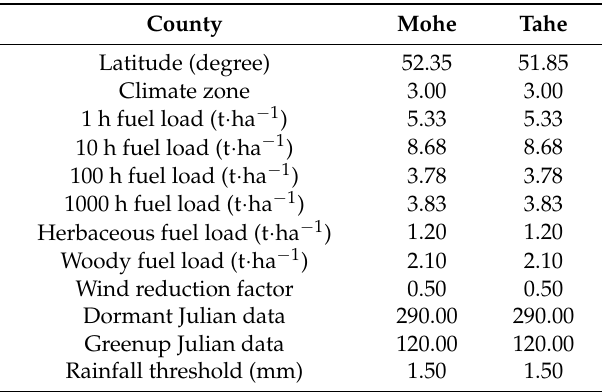
Table 1. Parameters used for IC